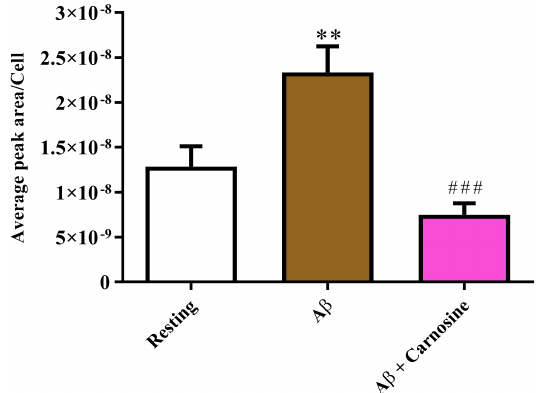
Figure 3. Detection of intracellular concentrations of NO (expressed as average peak area per cell) in resting RAW 264.7 cells and in RAW 264.7 cells stimulated with A β 1-42 oligomers (2 µ M) in the absence or presence of carnosine (20 mM; 1 h pre-treatment). Values are means ± SD of 3 independent experiments. Standard deviations are represented by vertical bars. ** significantly different from resting cells, p < 0.01; ### significantly different from A β 1-42 oligomer-treated cells, p <